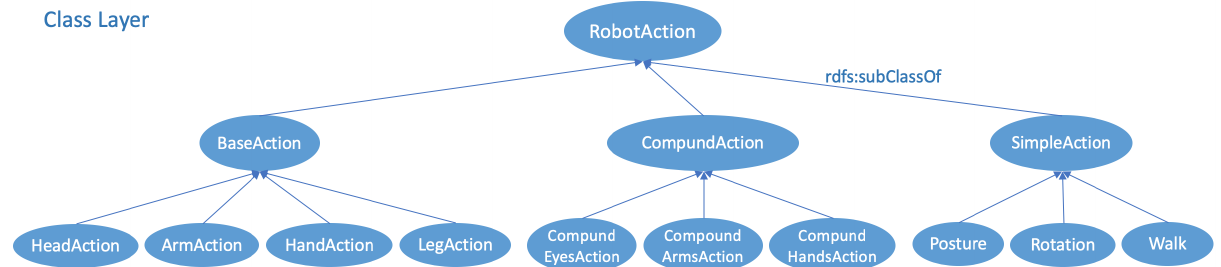
Figure 2. rdf:subClassOf relationship of actions in the Zora actions ontology.